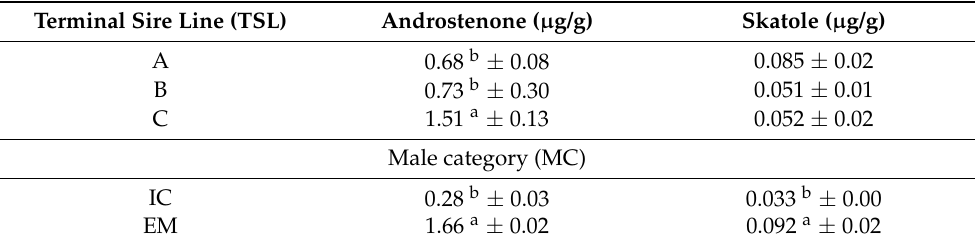
Table 3. Effect of terminal sire line and male category (LS means ± SEM) on androstenone and skatole